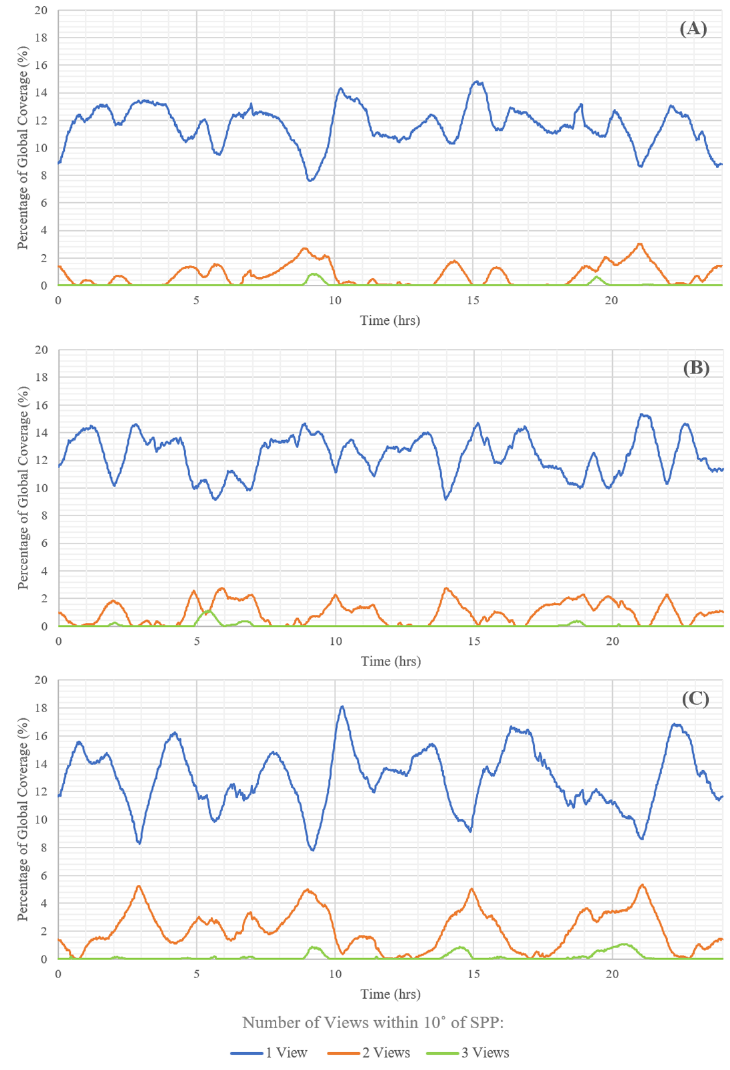
Figure 12. BRDF sampling quality showing the number of view angles within 10° of the SPP for ( A ) nine, ( B ) eleven, ( C ) thirteen satellite architectures. nine, ( B ) eleven, ( C ) thirteen satellite